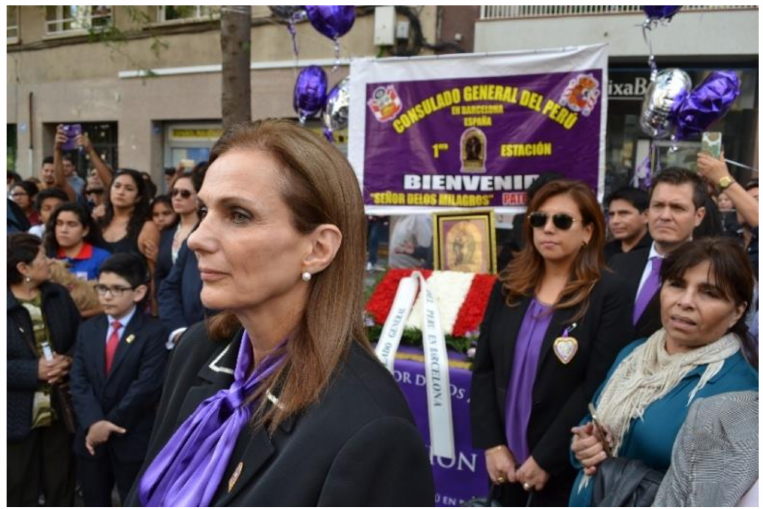
Figure 3. Current Consul of Peru at the first station with arrangement behind, October